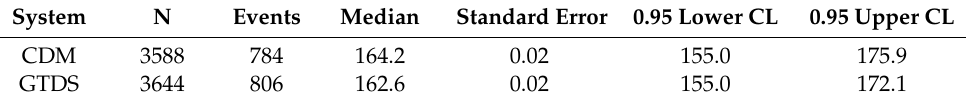
Table 5. Descriptive statistics of overall survival of patients diagnosed with breast cancer.